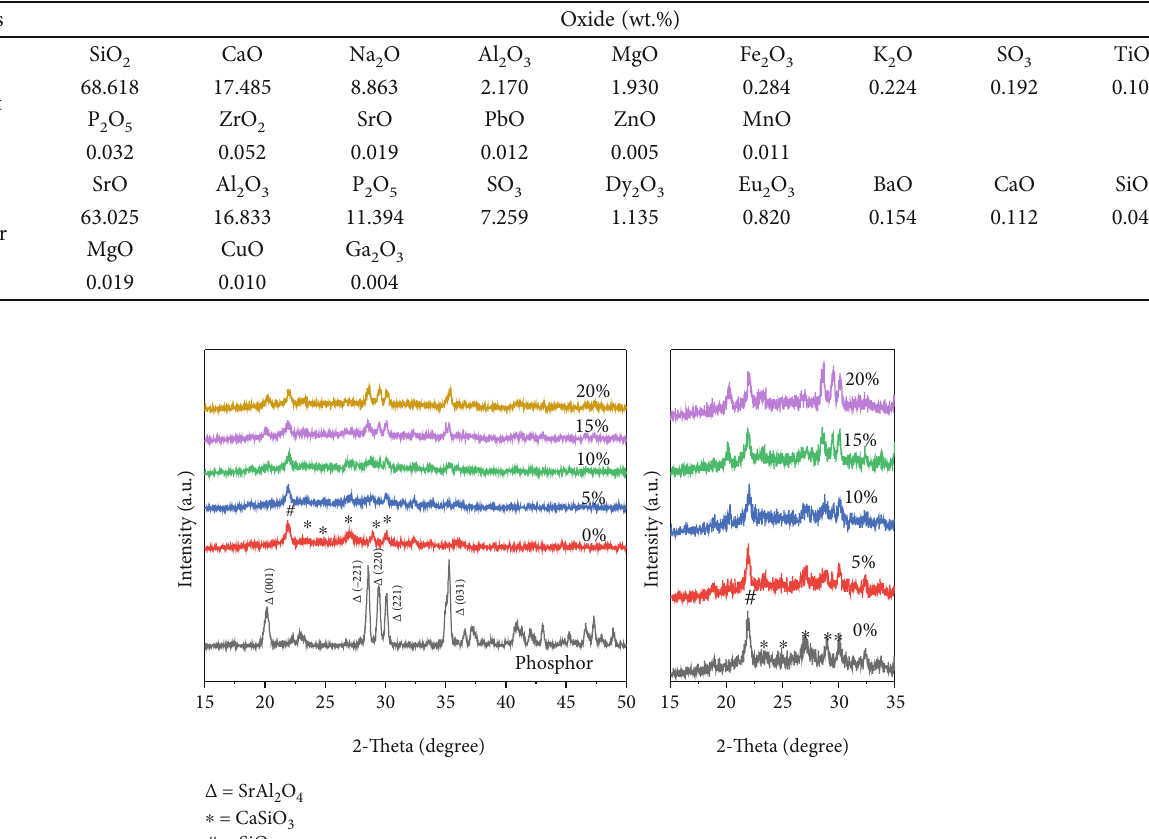
Table 1: Chemical composition (wt.%) of the glass and phosphor powders.